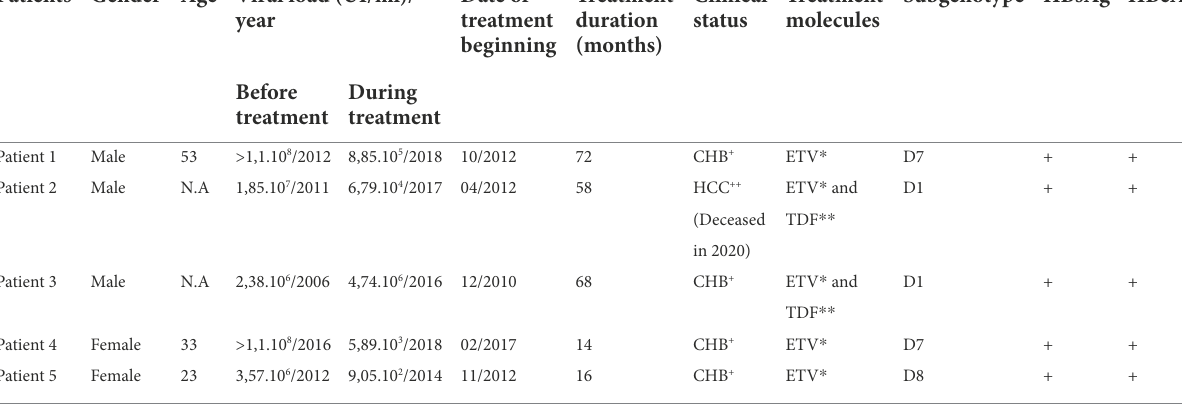
TABLE 1 Virological, treatment molecules, and treatment duration data for the five Tunisian chronic HBV infected patients before and during therapy. Patients Gender Age Viral load (UI/ml)/